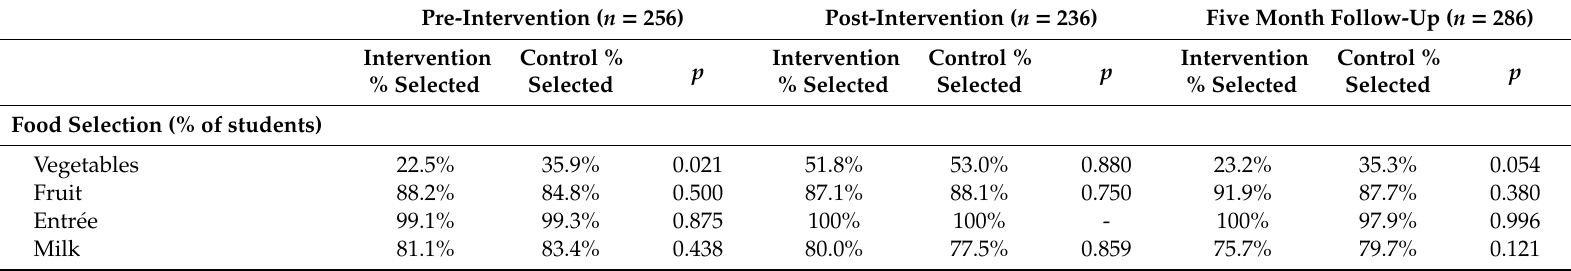
Note: The p -values presented are for the influence of condition (intervention vs. control) on food selection outcomes at each time point.